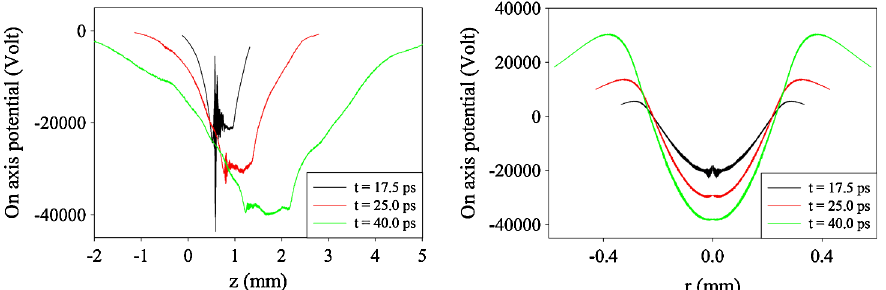
FIG. 9. Potential curves in longitudinal (left) and transversal (right) directions at three different positions along z . At t ¼ 40 ps , the space charge potential is reaching a maximum.